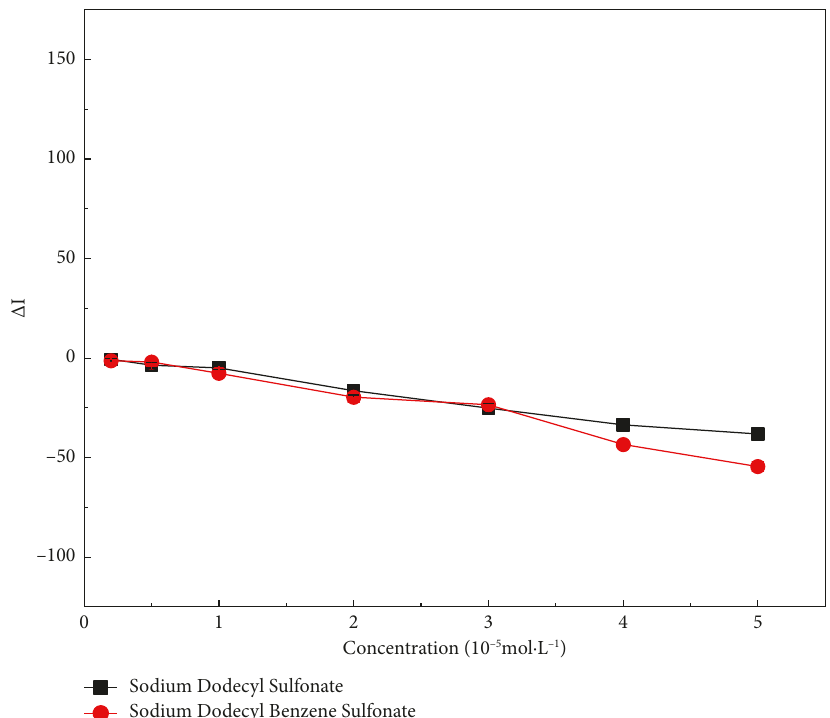
Figure 6: Resonant Rayleigh scattering spectra after addition of anionic surfactant to congo red-neomycin system. The concentration of sodium dodecyl benzene sulfonate and sodium dodecyl sulfonate: 0.2, 0.5, 1, 2, 3, 4, 5